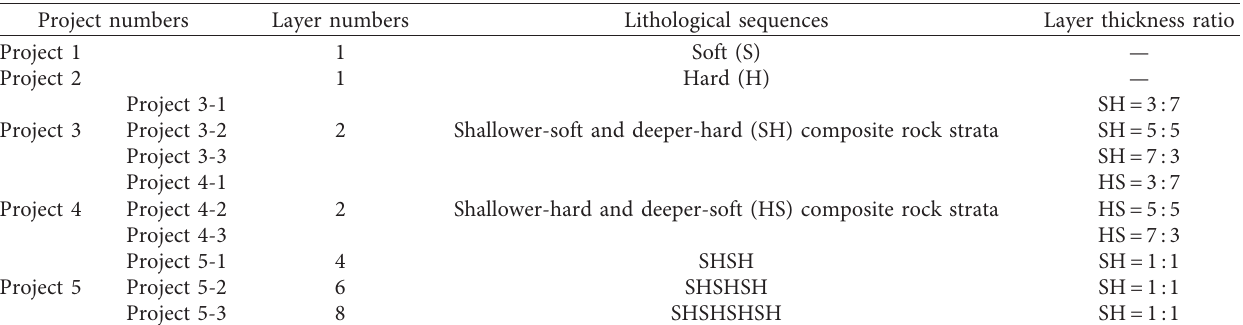
Figure 11: Shear stress (left) and axial force (right) distribution curves along the rock bolt in (a) hard rock and (b) soft Table 2: Numerical simulation schemes.